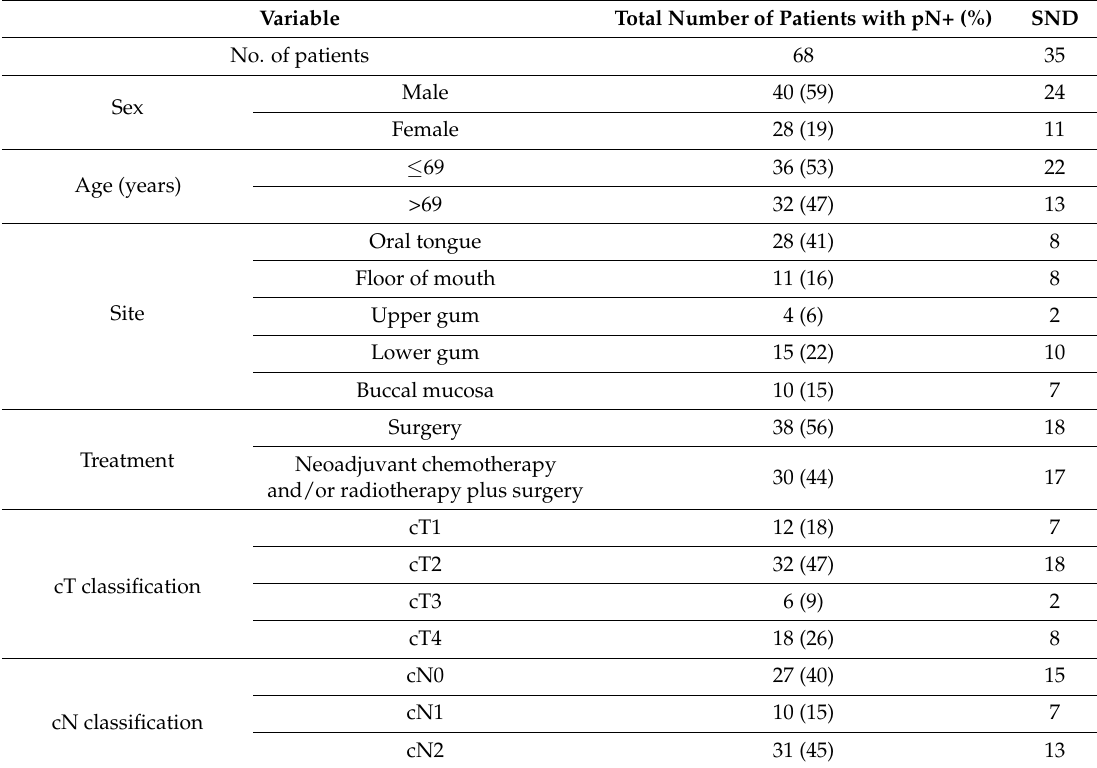
Table 3. Clinical variables in patients with node-positive oral squamous cell carcinoma. Variable Total Number of Patients with pN+ (%)